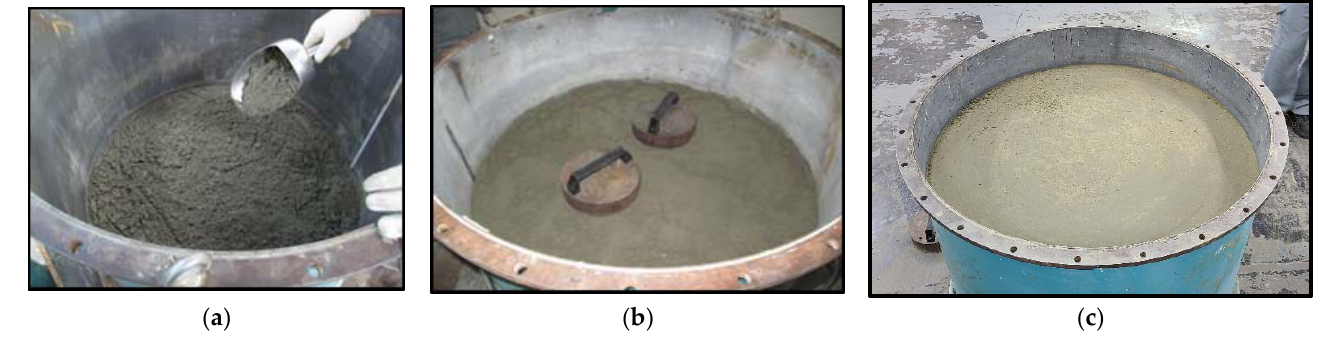
Figure 4. Soil foundation setting: ( a ) soil sprinkle; ( b ) soil compaction; ( c ) soil foundation set ‐ up. Table 3. Fundamental properties of soil foundation for conventional and hybrid monopiles.